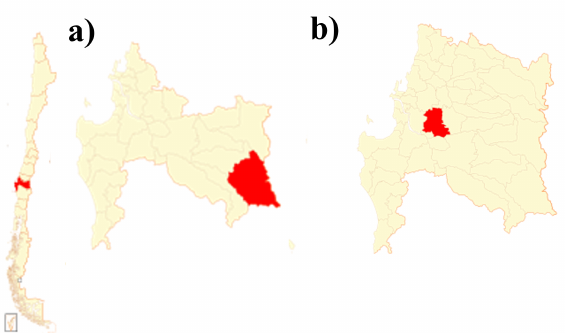
Figure 1. Map of Chile highlighting ( a ) the Pitril sector, Alto Biobío Commune, and ( b ) Yumbel. Both areas are located in the Biobío Region between 36º26 (cid:48) and 38º29 (cid:48) south